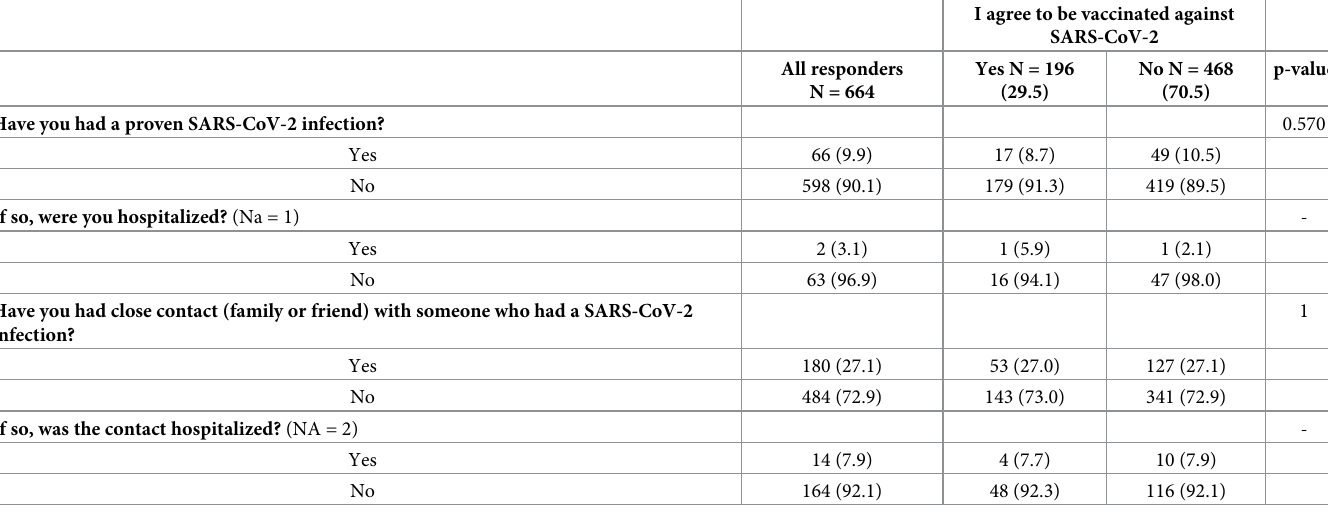
As expected, our results indicated a lower rate of acceptance of COVID-19 vaccination among pregnant women, i.e. 29.5%, than in the general population. In a recent meta-analysis, Table 3. Exposure to COVID-19 and perceptions of the SARS-CoV-2 vaccine. I agree to be vaccinated against